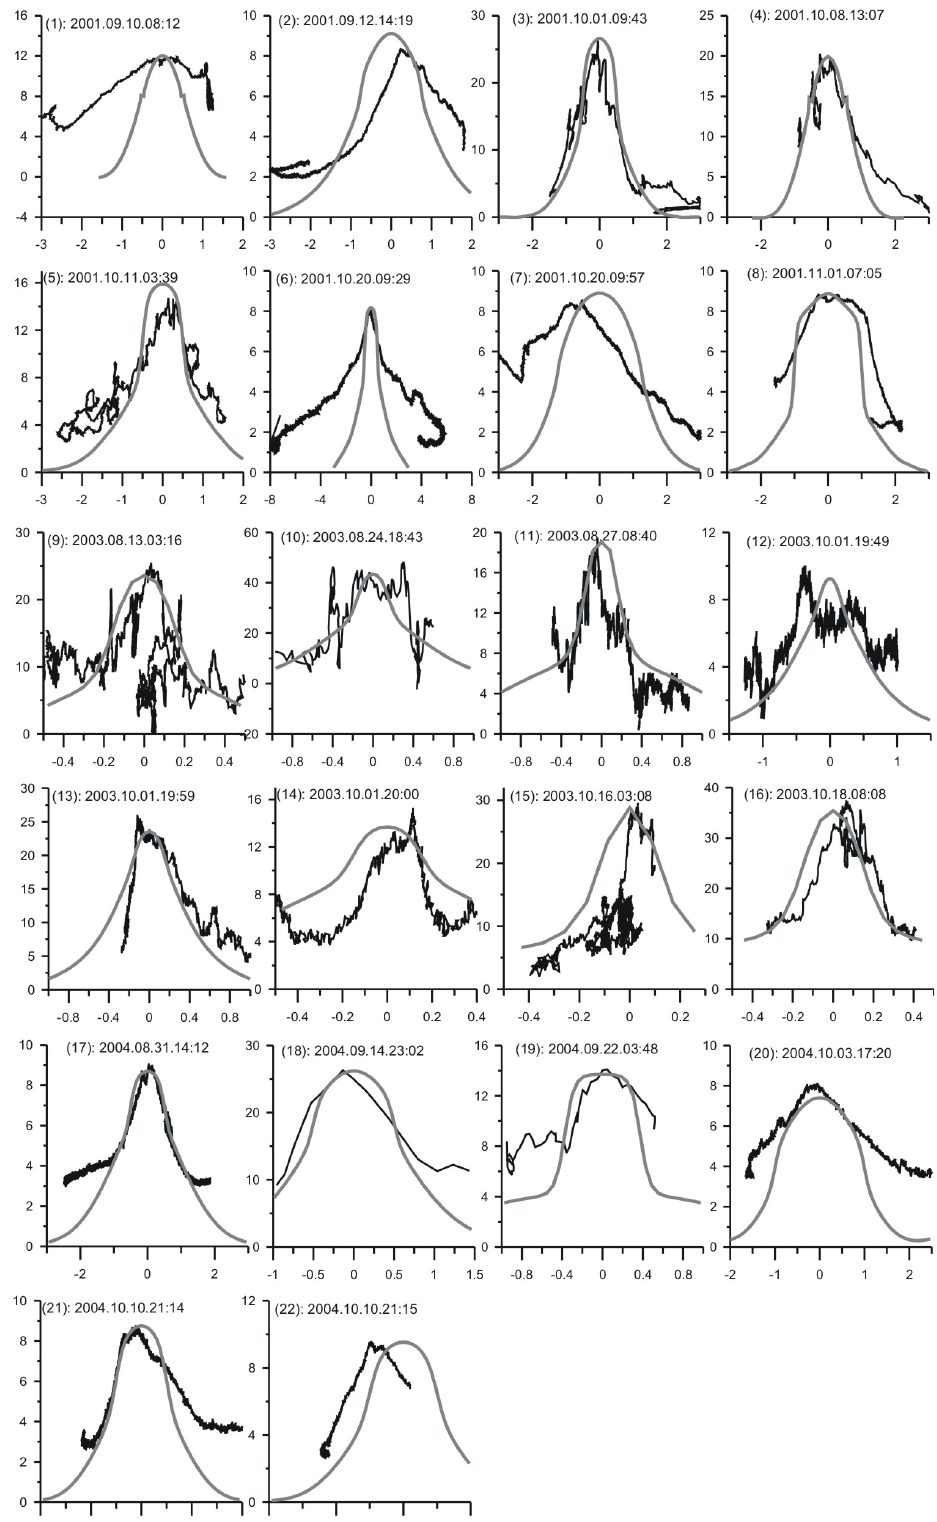
Fig. 10. Comparison of experimental (black) and model (grey) current density profiles w.r.t. coordinate along the